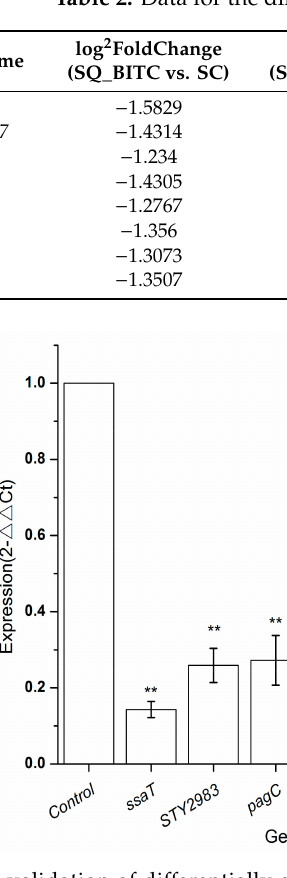
Figure 4. qRT-PCR validation of di ff erentially expressed genes (DEGs). The relative expressions of ssaT , STY2983 , pagC , yscR , sseB , sifB , ssaH and sseD were compared with 16S rRNA in the control group. The bars are expressed as the means ± SD from three independent replicates. ‘*’ indicates significant di ff erences ( p < 0.05). ‘**’ indicates extremely significant di ff erences ( p <